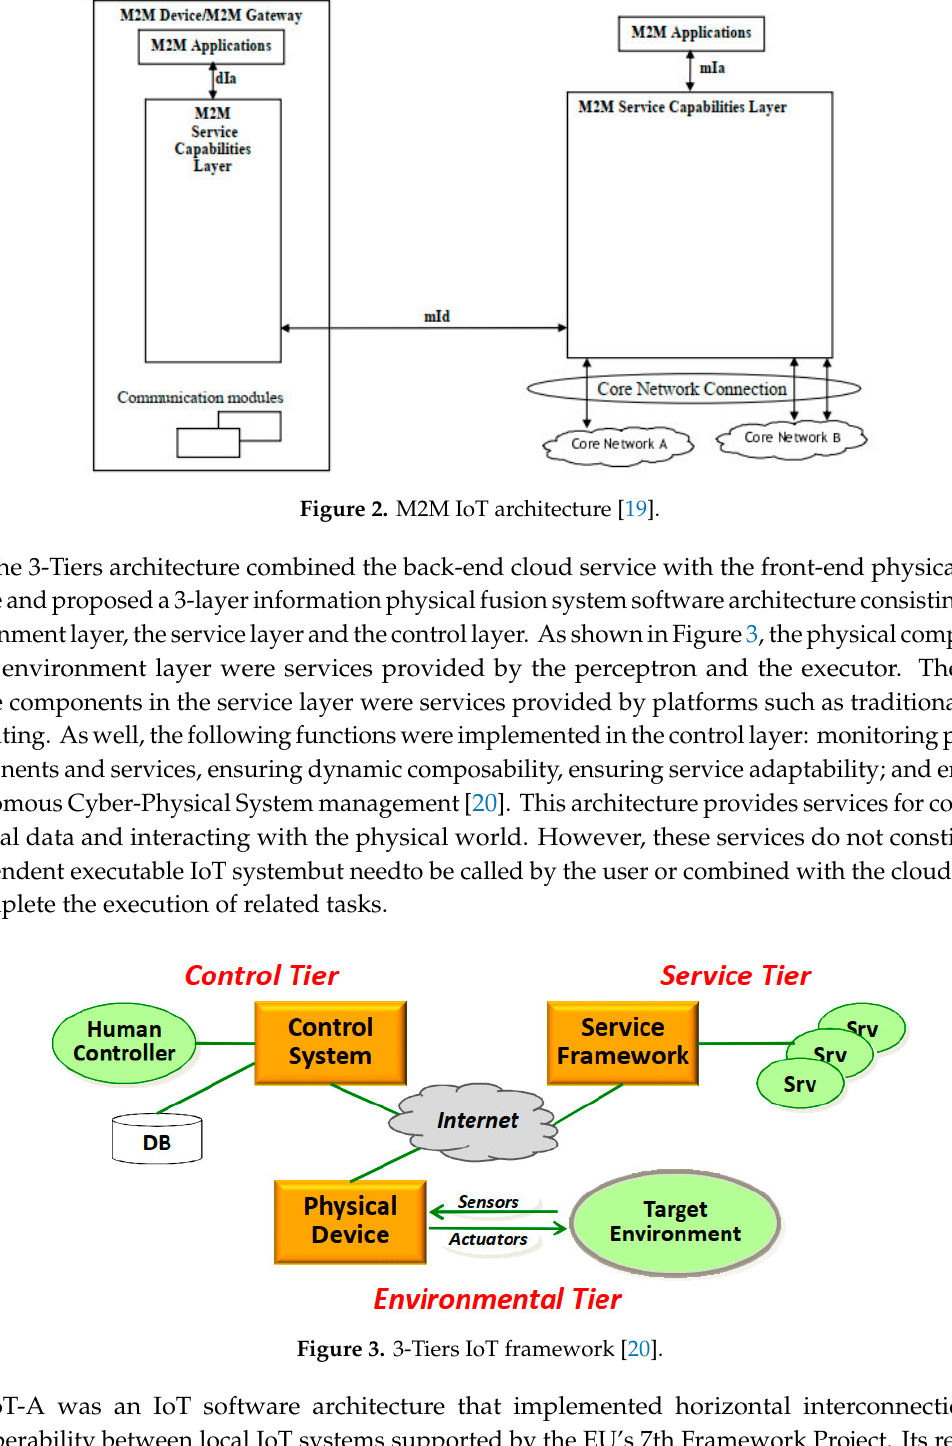
Figure 3. 3-Tiers IoT framework [20].